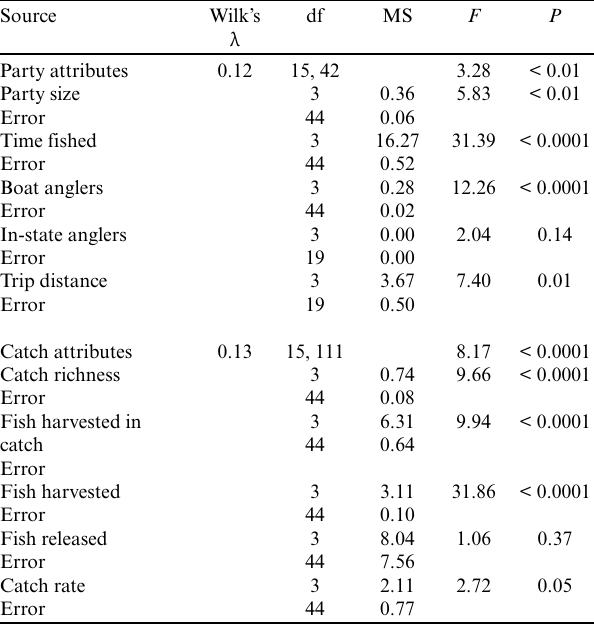
Table 2 . Multivariate analysis of variance (MANOVA) and univariate analysis for the effect of water body size (extra small, small, medium, and large) on party (top) and catch (bottom) attributes of a regional recreational fishery in Nebraska. Social attributes include party size, time fished, boat anglers, in-state anglers, and trip distance. Catch attributes include catch richness, fish harvested in catch, fish harvested, fish released, and catch rate. Attributes were measured at the party-level but averaged and assessed at the water body level, i.e., experimental unit.